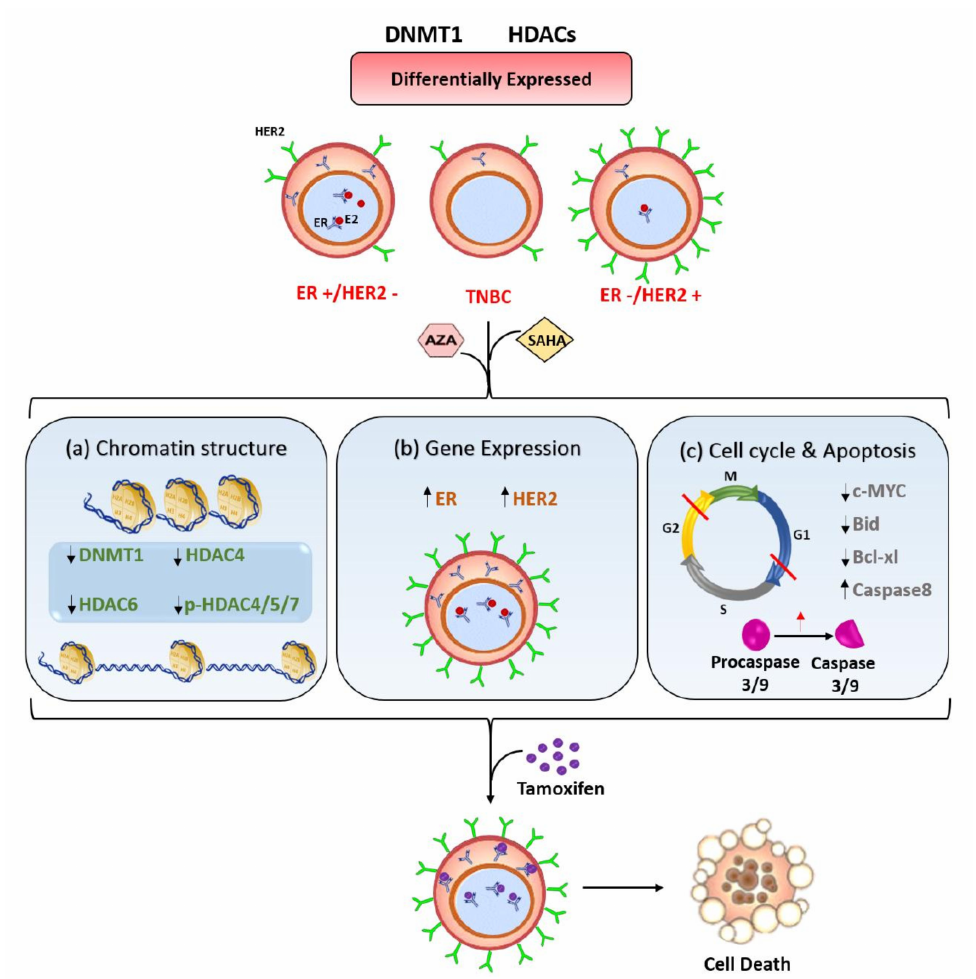
Figure 7. Model for the effect of SAHA and 5-aza-dc on the response of TNBC cells to TAM. BC cells with different hormonal status vary in the expression pattern of DNMT1 and different HDACs. Epigenetic modifiers such as SAHA and 5-aza-dc result in ( a ) modifying the chromatin structure by reducing DNMT1 expression and inhibiting the activity and phosphorylation of different HDACs, ( b ) upregulating the expression of ER α and HER2/ERBB2 and ( c ) arresting the cell cycle in G1 and G2 phases and inducing apoptosis. These changes consequently increase the response of TNBC cells to